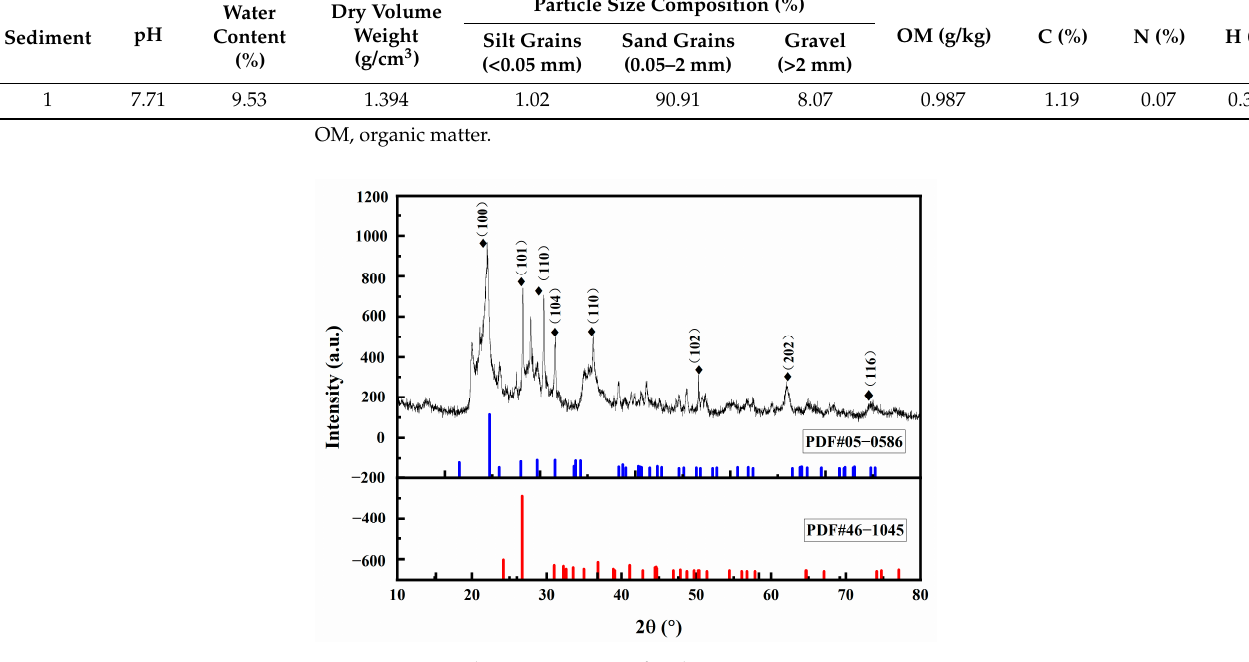
Figure 1. XRD characterization of sediments.